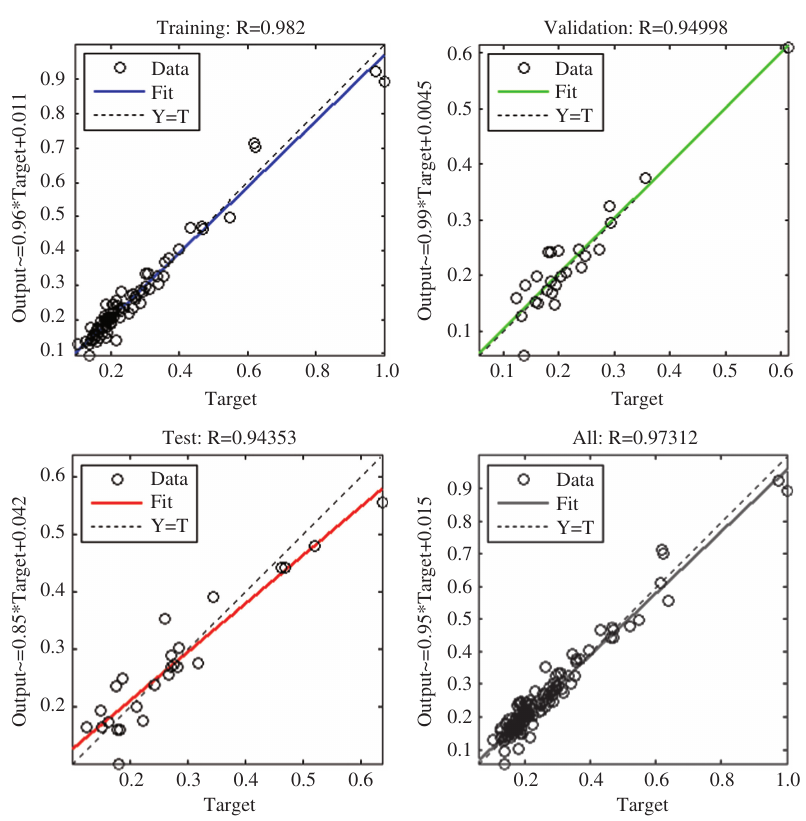
Figure 7 Regressions of training, validation, testing, and all data simulated by NN